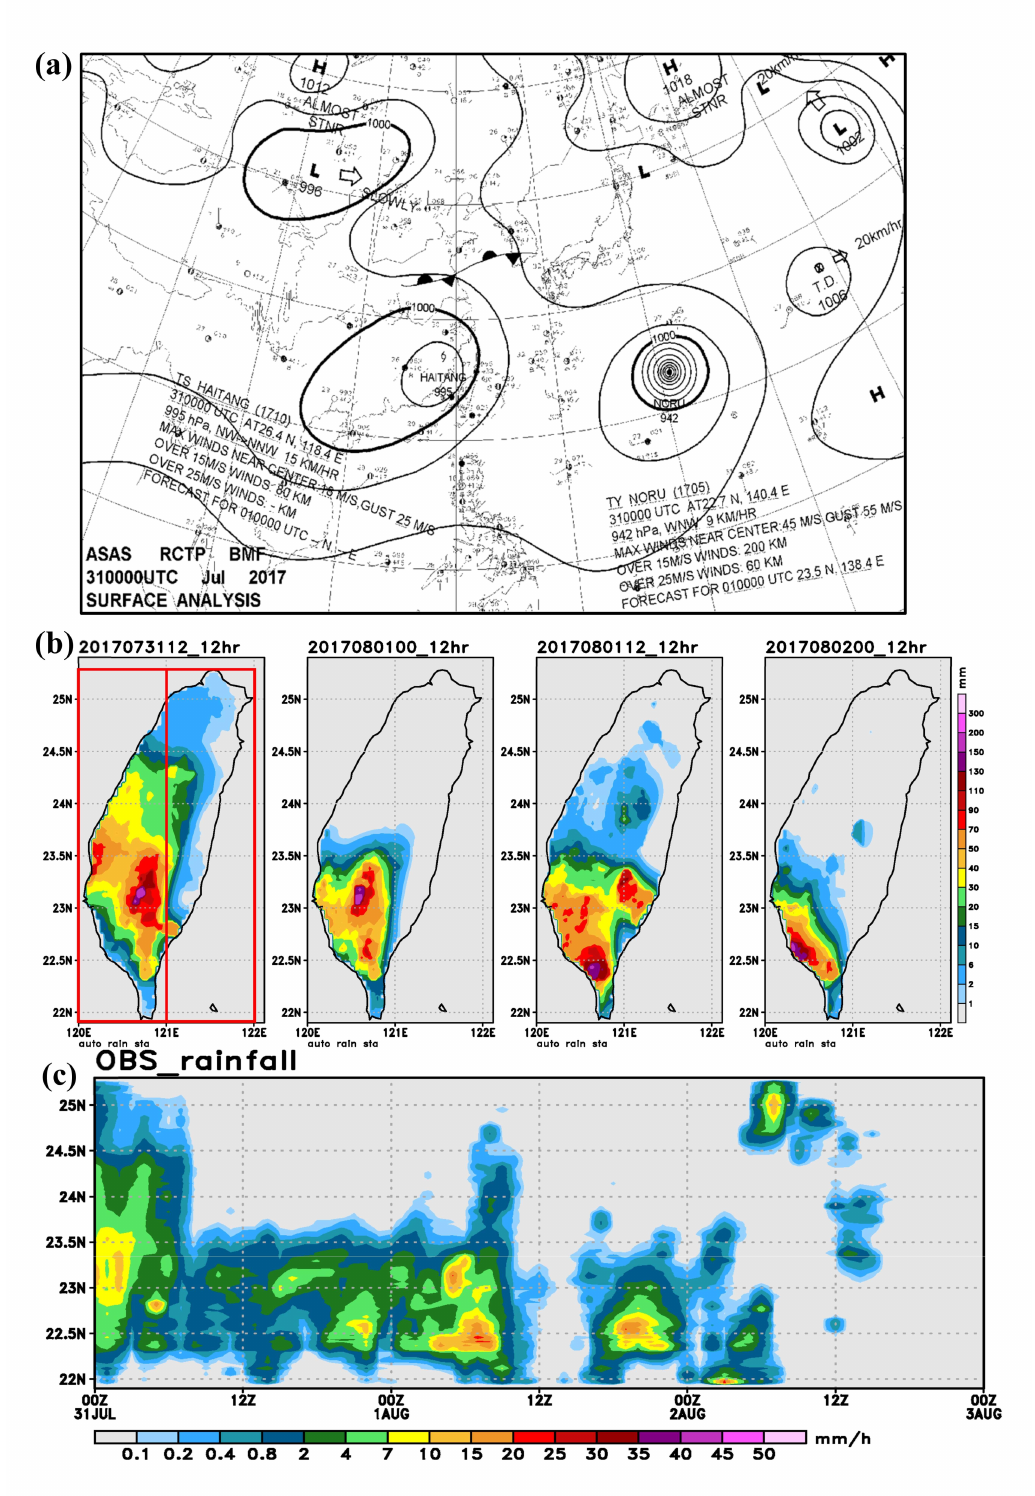
Figure 1. ( a ) Surface weather map at 0000 UTC 31 July 2017 from the Central Weather Bureau of Taiwan (CWB). ( b ) Twelve- hour accumulated rainfall (mm) from rain gauge stations ending at 1200 UTC 31 July, 0000 UTC 1 August, 1200 UTC 1 August, and 0000 UTC 2 August 2017 (from left to right). ( c ) Time evolution of the longitudinally averaged rain intensity (mm h − 1 ) along a north–south line shown in the red box of the leftmost panel of ( b ). The abscissa is the time from 0000 UTC 31 July to 0000 UTC 3 August 2017, and the ordinate is the latitude from southern to northern